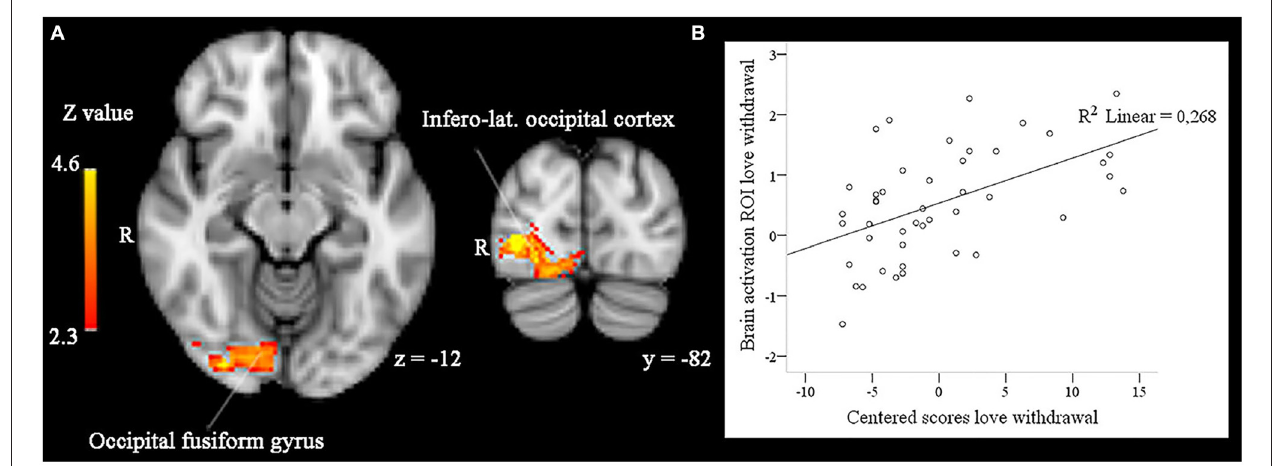
FIGURE 3 | (A) In right infero-lateral occipital cortex and right occipital fusiform gyrus the effect of face familiarity (enhanced activity to familiar compared to unfamiliar faces) is significantly and positively related to participants’ scores on love withdrawal in whole-brain analyses, p < 0.05, corrected by cluster threshold ( Z > 2.3). (B) Scatterplot between the activity difference (familiar > unfamiliar) found in these areas and participants’ centered scores on love withdrawal.